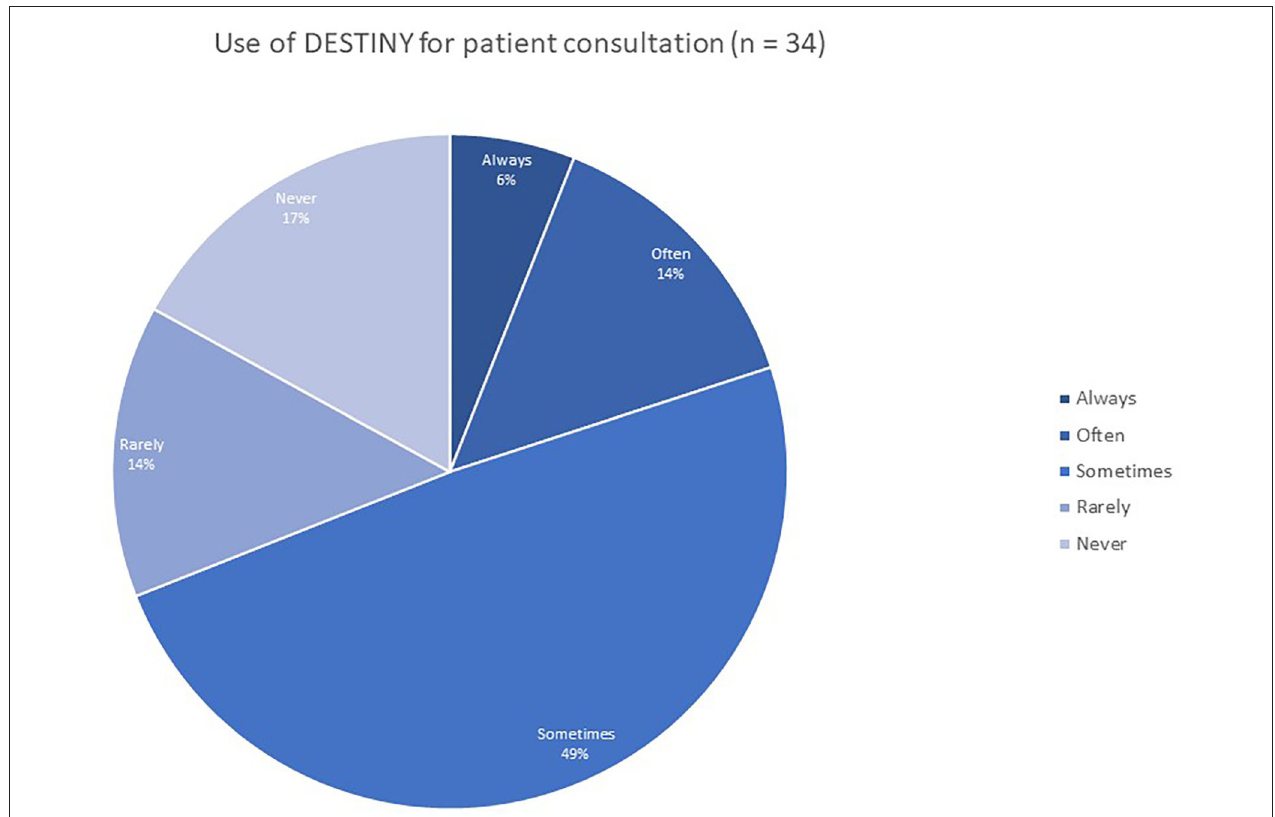
FIGURE 7 | Use of DESTINY for patient